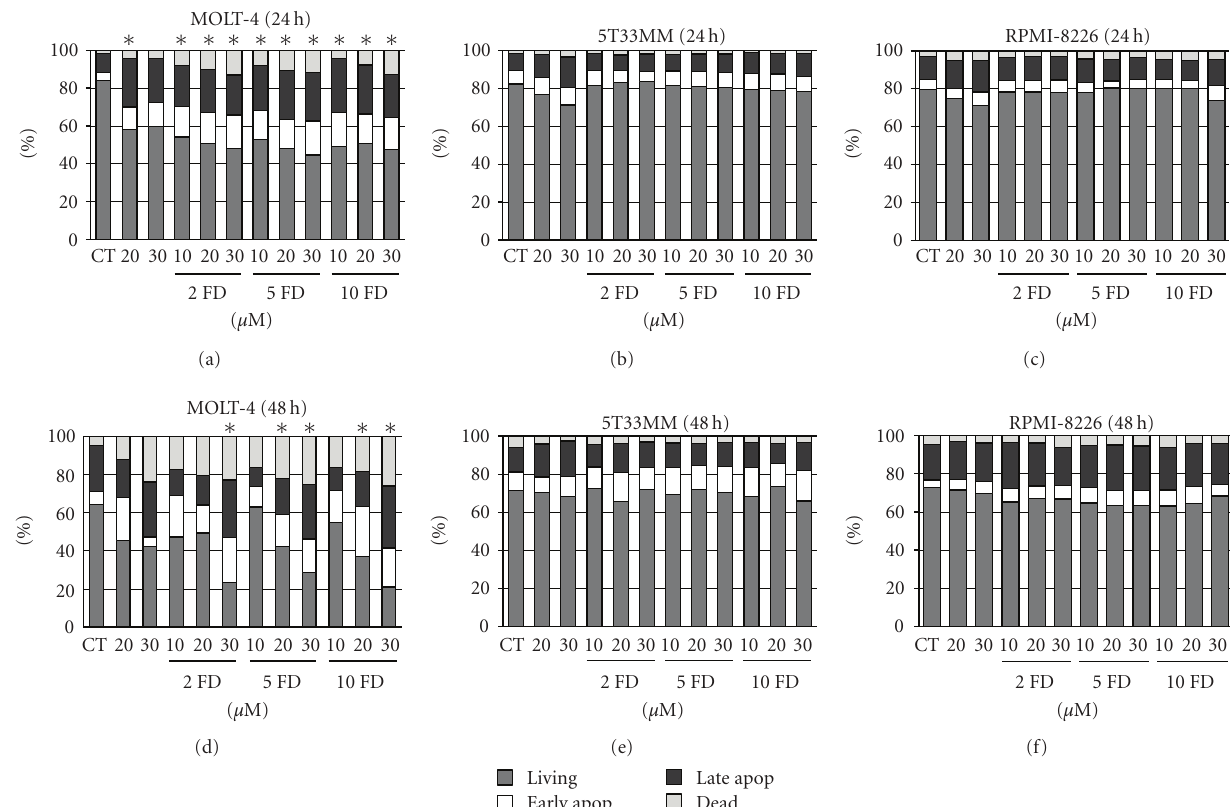
Figure 4: E ff ect of forodesine on apoptosis of MM cells. The % live, early apoptotic, late apoptotic, and dead cells are shown for MOLT-4, 5T33MM, and RPMI-8226 cells, treated with di ff erent concentrations of forodesine and dGuo at 24 hours (a, b, c) and 48 hours (d, e, f). The mean value is shown of 3 independent experiments; ∗ P < . 05 compared to CT, CT = control, and FD = forodesine. MOLT-4 (24h)